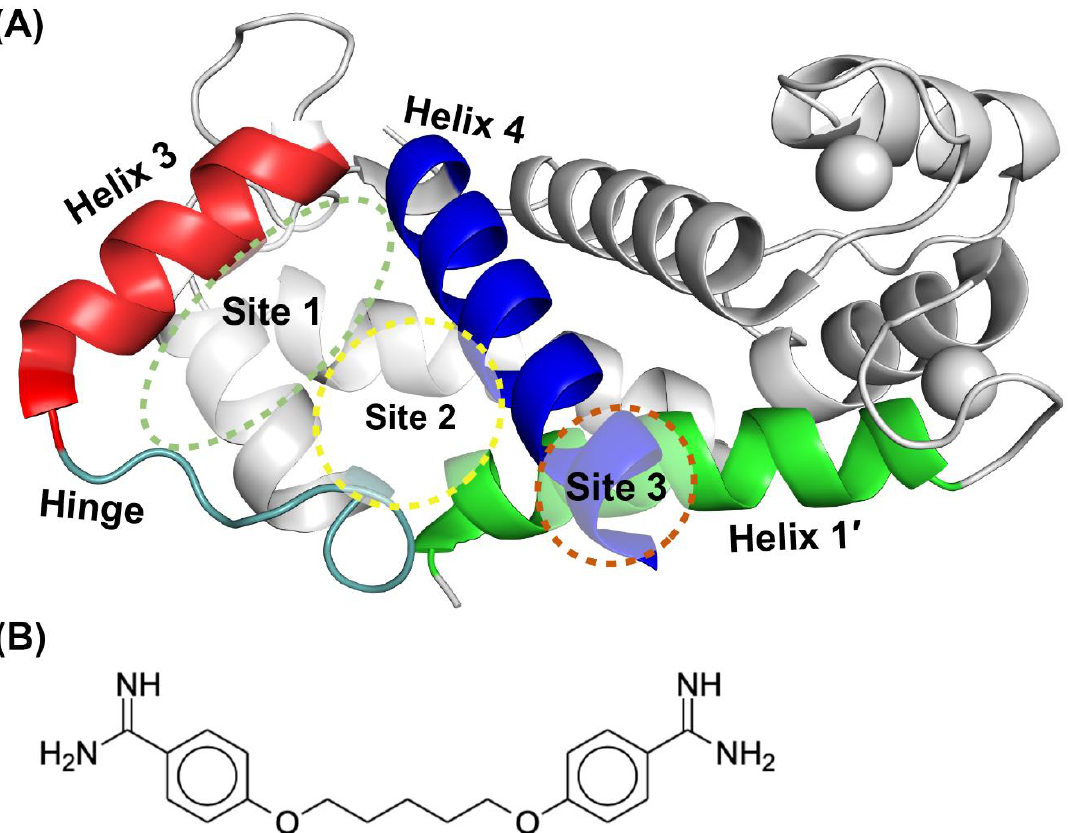
Figure 1. Three binding sites identified on S100B. ( A ) Site 1 (green dashed line) is comprised of Helix 3 (red), Helix 4 (blue) and the Hinge region (cyan). Inhibitors that lie in Site 2 (yellow dashed line) have interactions with residues within Helix 4 (blue) and the Hinge region (cyan). Site 3 (copper dashed line) interactions occur with residues of Helix 1′ (chain B, green), and Helix 4 (blue). (Figure adapted from literature) [16]. ( B ) Structure of the S100B inhibitor (SBi1), pentamidine.